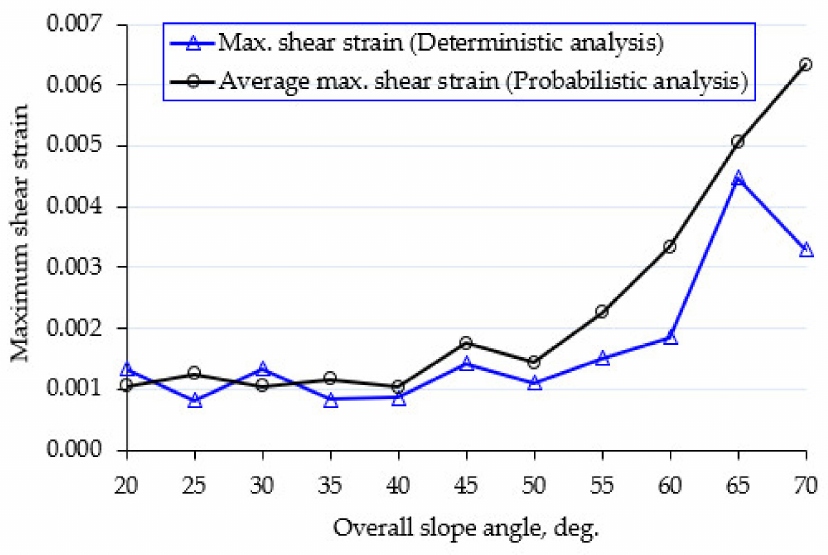
Figure 6. Maximum shear strain at different overall slope angles (deterministic vs. probabilistic